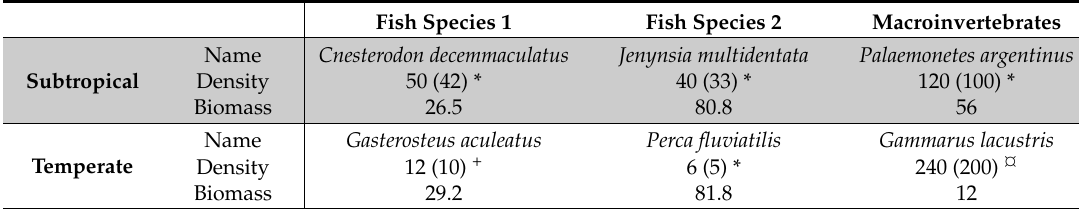
Table 2. Fish and macroinvertebrate predator species and numbers added to the mesocosms in the treatments: F (fish); F + INV (fish + predatory macroinvertebrates) and INV (predatory macroinvertebrates). F and F + INV treatments had individuals of both fish species (fish densities at the beginning, expressed as ind. m − 2 , are given in parenthesis). For each species, biomass was estimated by multiplying introduced densities by average weight and expressed in grams of fresh weight. The selected densities of predators were based on information in the literature: * [23]; + [50];